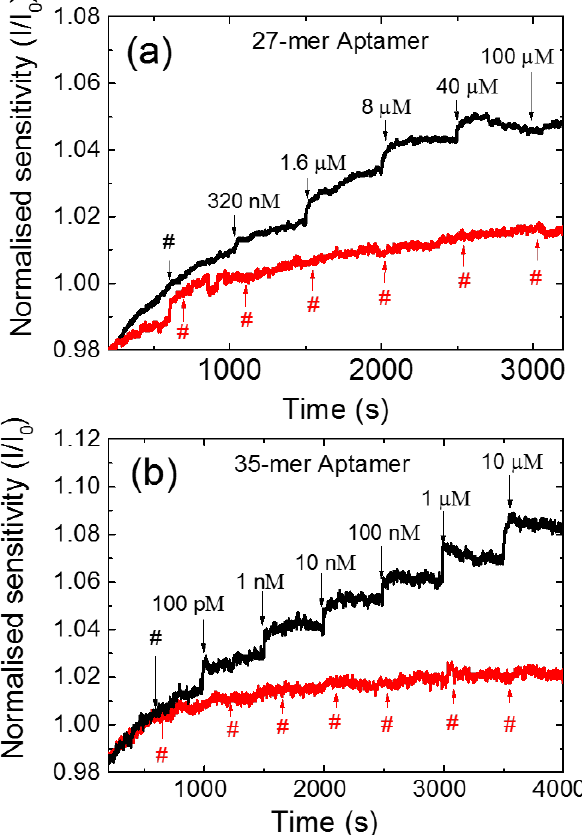
Figure 3. The normalized current response to adenosine for ( a ) the 27-mer adenosine aptamer and ( b ) the 35-mer adenosine aptamer (black line) immobilised CNT FET aptasensors; and control measurement with successive addition of 2 mM Tris-HCl buffer (red line).